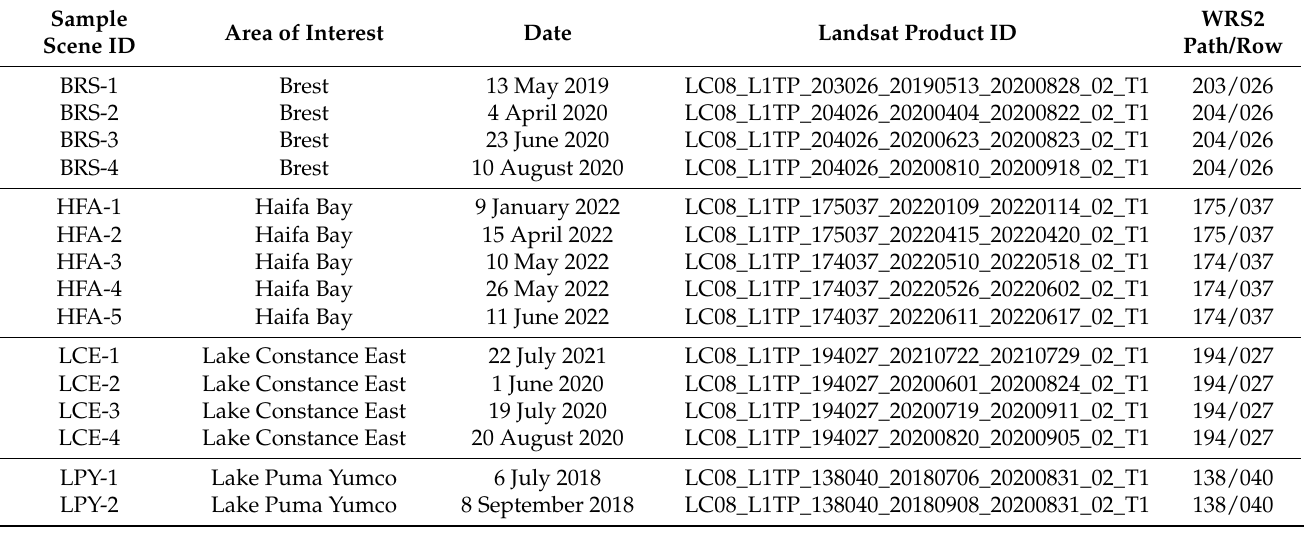
Table 3. List of OLI sample scenes to which GRCM was applied.